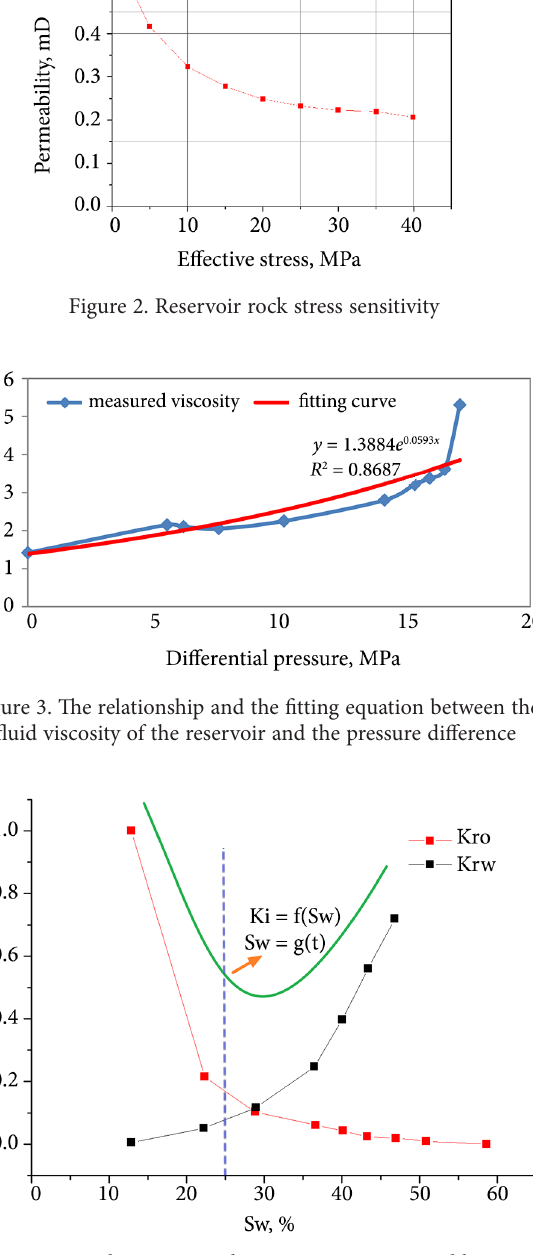
Figure 4. Oil-water two-phase seepage curve in oil